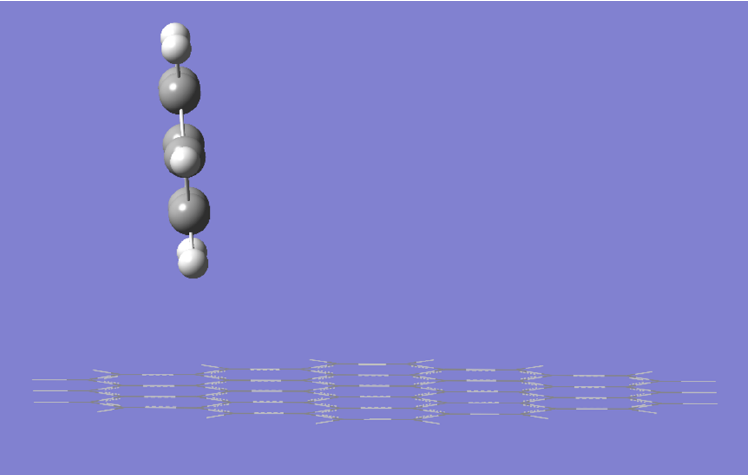
Figure 3. The structure V obtained at the DFT/DFTB level of theory.